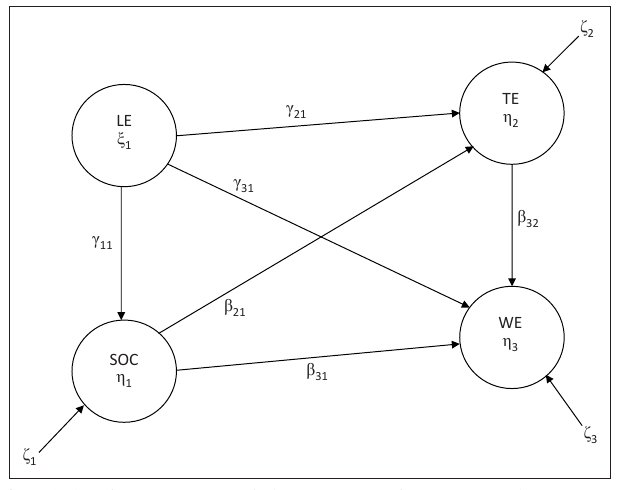
FIGURE 3: Revised work engagement structural